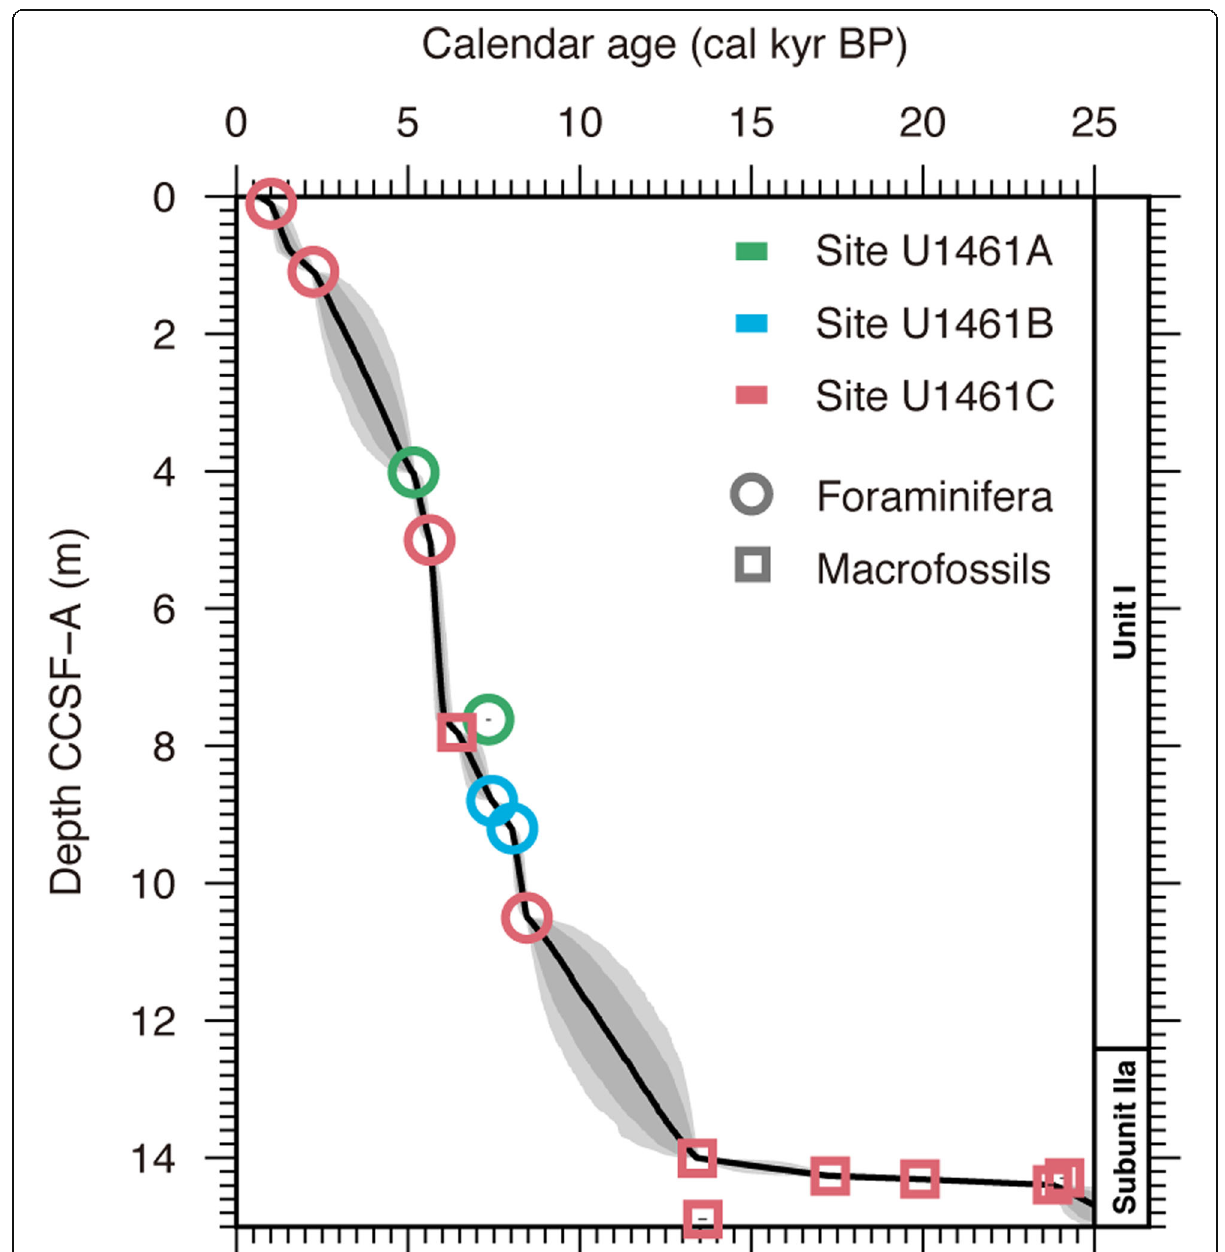
Fig. 3 Site U1461 age-depth model by radiocarbon dating. Bchron (Haslett and Parnell 2008; Parnell et al. 2008) age-depth models with calibrated ages using Marine 13 (Reimer et al. 2013). The black line is the mean calibrated chronology; the lighter grey shade indicates the 97.5% range, and the darker grey shade indicates the 90%